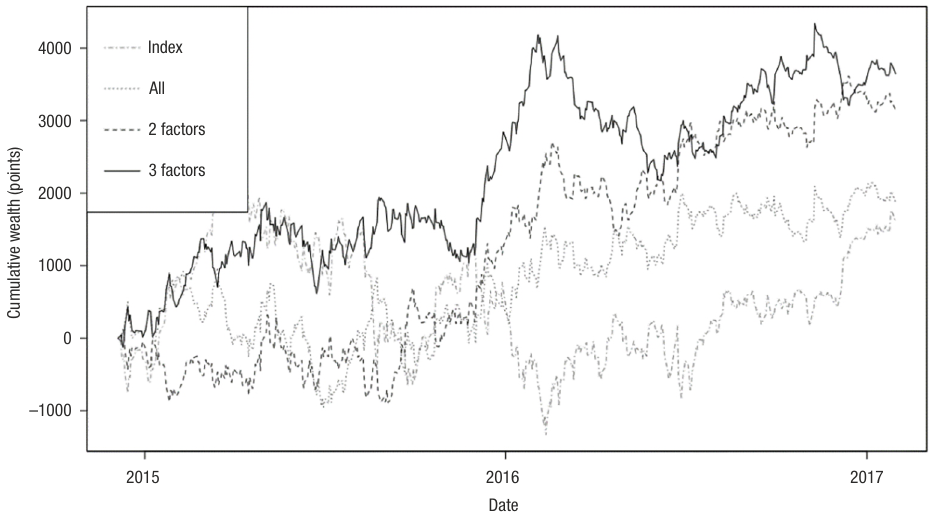
Figure 4. Cumulative wealth of the investment strategy vs.